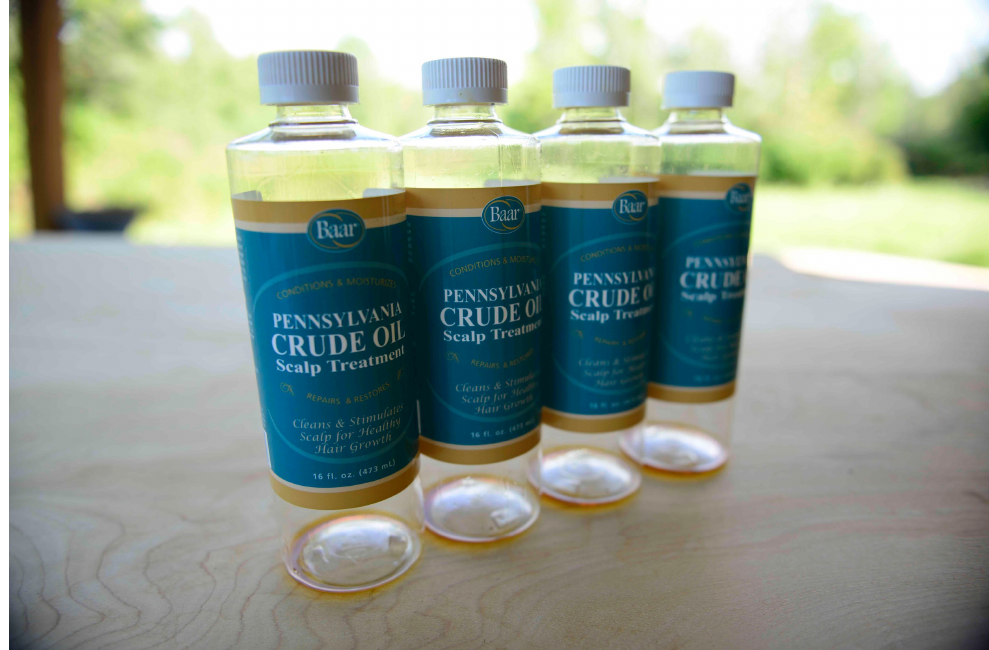
Figure 2: Four empty bottles of Crudoleum Pennsylvania Crude Oil Scalp Treatment, from Baar Products Inc. Photo: Elia